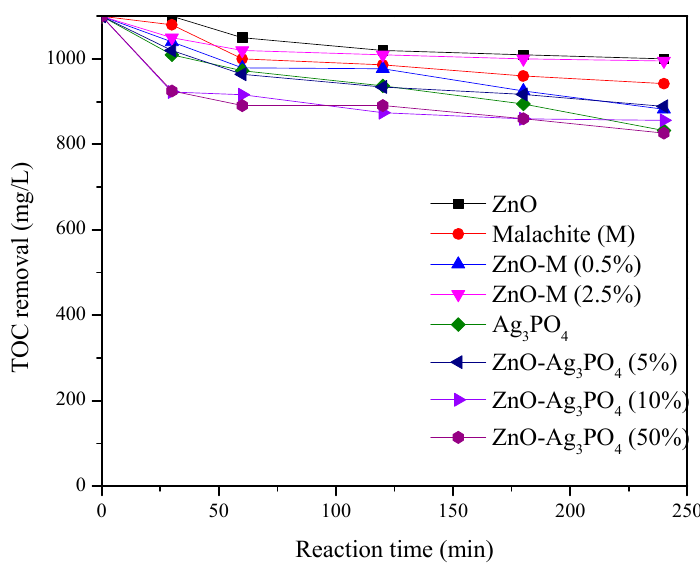
Figure 6. Total organic carbon content in handmade textile staining wastewater samples. Photodegradation of dyestuffs in the handmade textile staining wastewater samples during